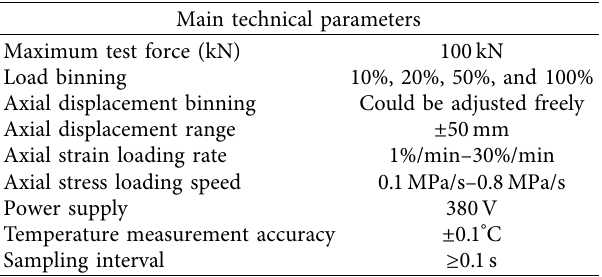
Figure 1: WDT-100 frozen soil experiment machine. Table 1: Main technical parameters single-axle frozen soil ex- periment